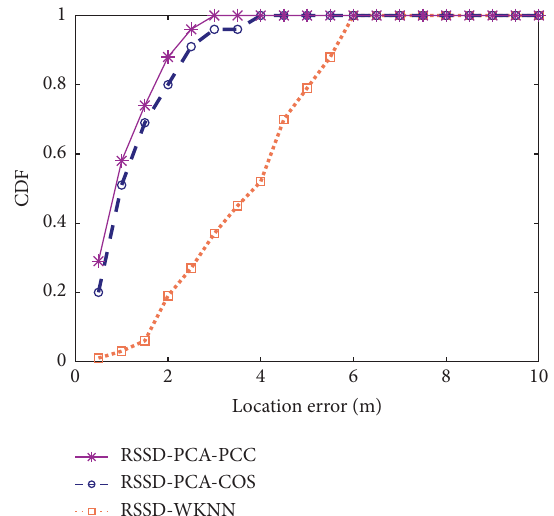
Figure 5: CDF comparisons of location errors among RSSD-WKNN, RSSD-PCA-COS, and proposed RSSD-PCA-PCC with 2m grid distance, 4 APs, and K �